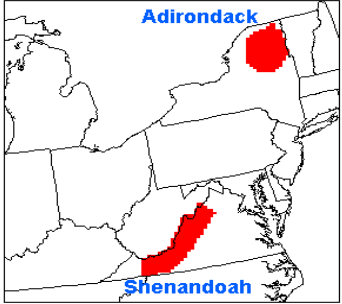
Figure 4. Regions used for analysis of variability in TSO Adirondack region includes 18 grid cells in a 36-km modeling grid and 164 cells in a 12-km grid. The Shenandoah region has 23 cells in a 36-km grid and 207 cells in a 12-km